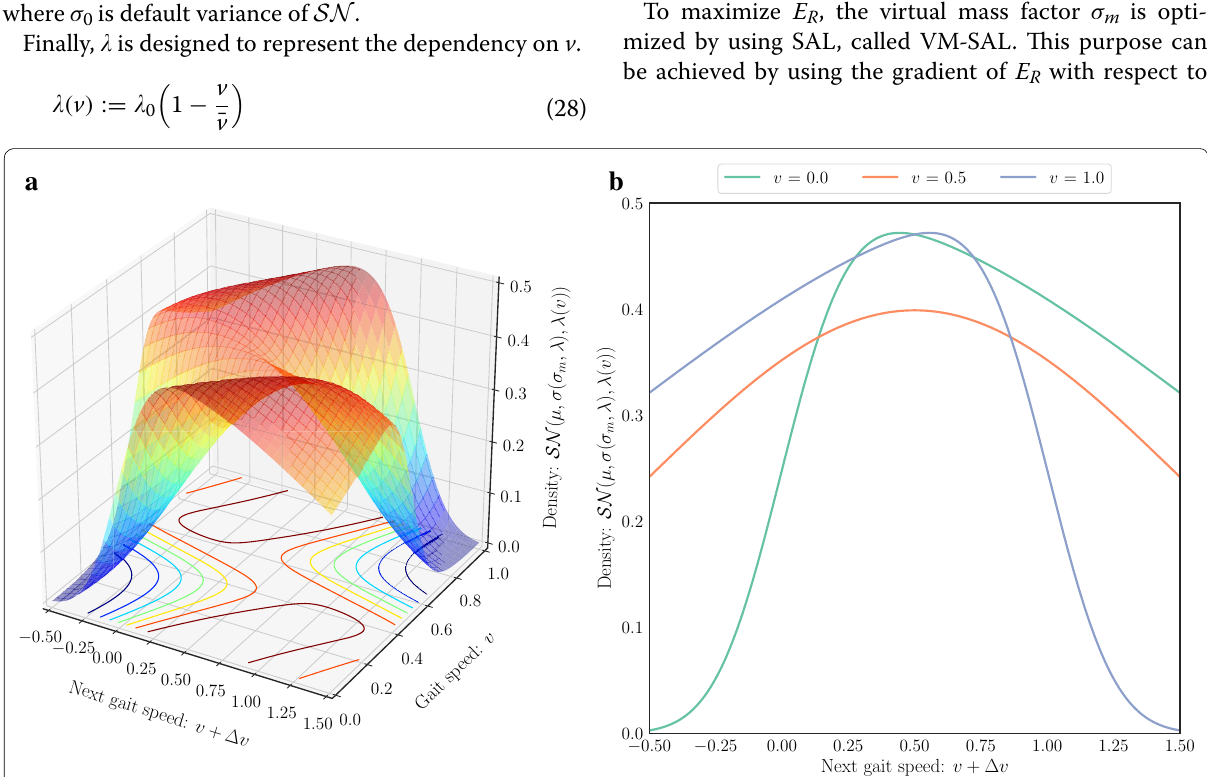
Fig. 5 Skewness of SN depending on v when v is smaller than tends to decelerate v . a Overview, b typical